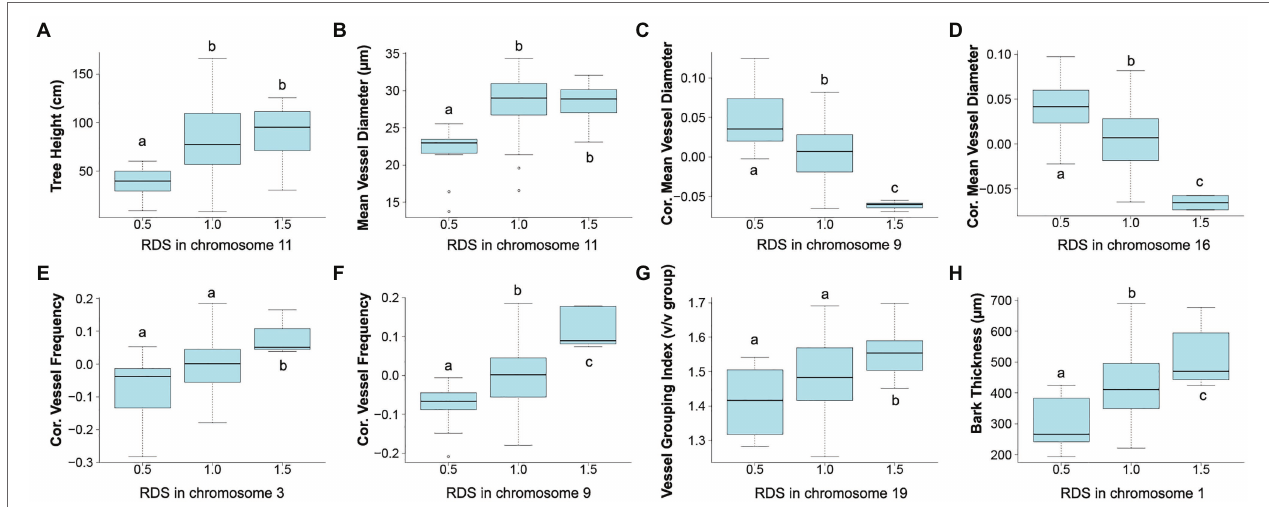
FIGURE 7 | Relationship between trait value and relative dosage scores (RDSs) at genomic bins detected by dQTL analyses. Each boxplot shows all genotypes grouped by RDS at the most significant dQTL detected for each trait. Selected dQTLs were located on chromosome 11 for tree height (A) and MVD (B) , chromosome 9 (C) and chromosome 16 (D) for cMVD, chromosome 3 (E) and chromosome 9 (F) for cVF, chromosome 19 for VGI (G) , and chromosome 1 for bark thickness (H) . Tukey pairwise comparisons were used to visualize significant differences in mean trait values between the groups; means that share a letter are not significantly different ( p >